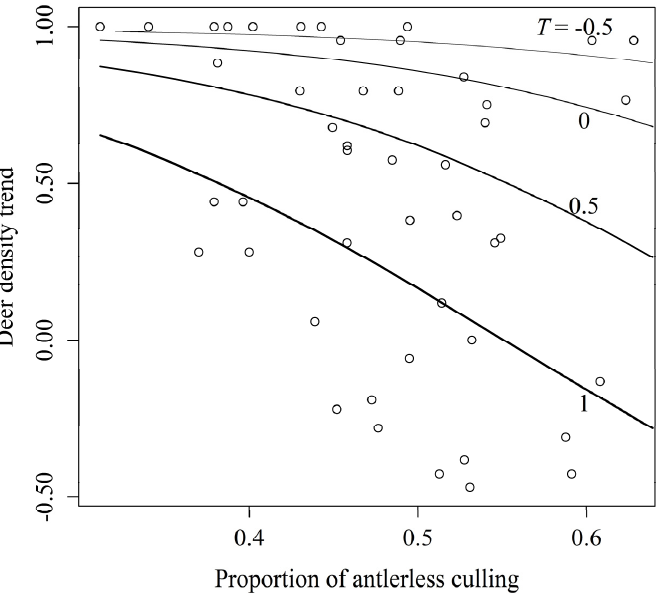
Figure 3. Effects of antlerless culling on sika deer density trends in Fukuoka Prefecture, Japan. Four lines indicate difference of trend of culling pressure, T , and values in the figure are T . Plots show measured values.